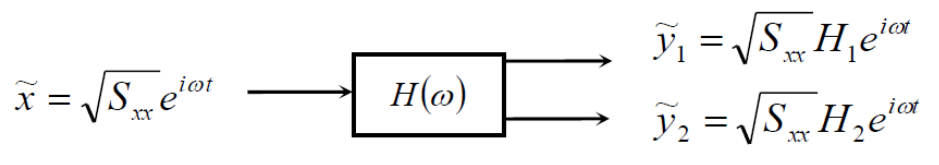
Figure 1. Basic theory of Figure 1 Basic theory of PEM.